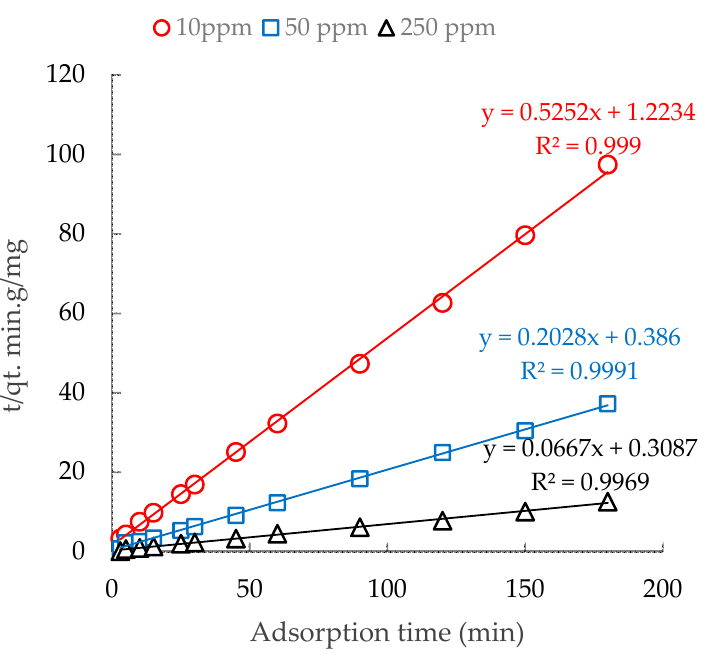
Figure 8. Pseudo-second-order model for CFX-adsorption kinetic onto PMA with three initial CFX concentrations . Table 3. Parameters of adsorption kinetics of ciprofloxacin (CFX) onto PMA. C i (mg/L)